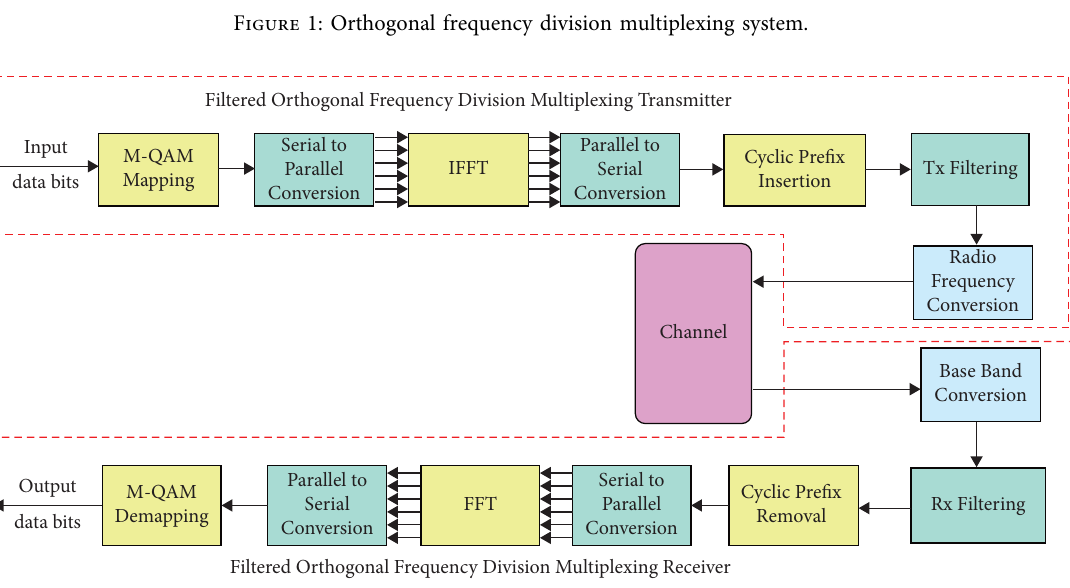
Figure 1: Orthogonal frequency division multiplexing system.